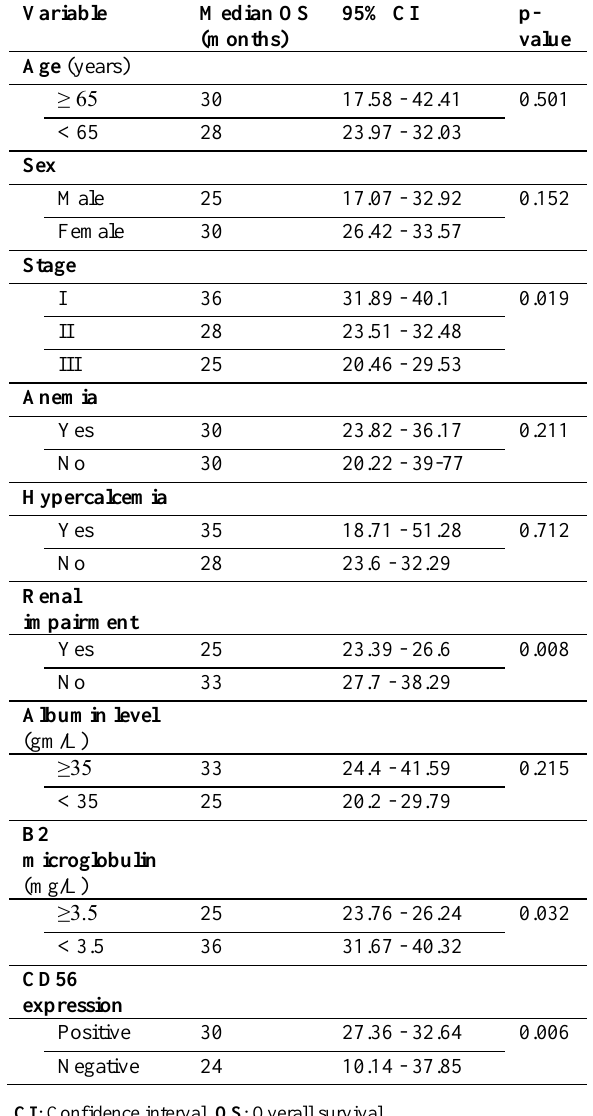
Table 2: Relation between CD56 expression status and baseline characteristics